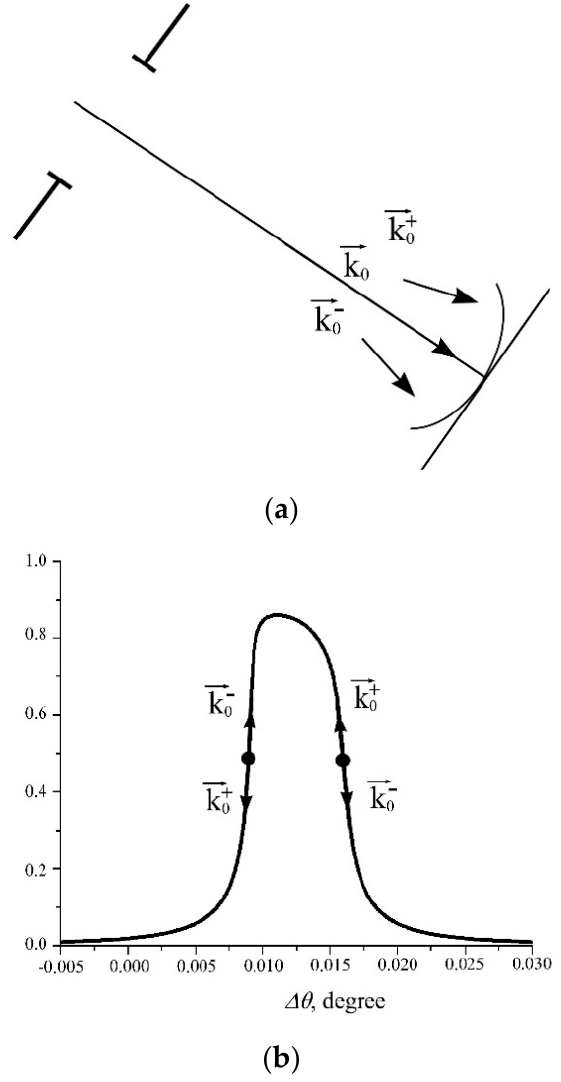
Figure 3. Interpretation of transverse beam modulation in the reflection from the crystal analyzer: ( a ) decomposition into wave vectors (plane fronts); ( b ) contrast formation on the curve of the diffraction reflection.